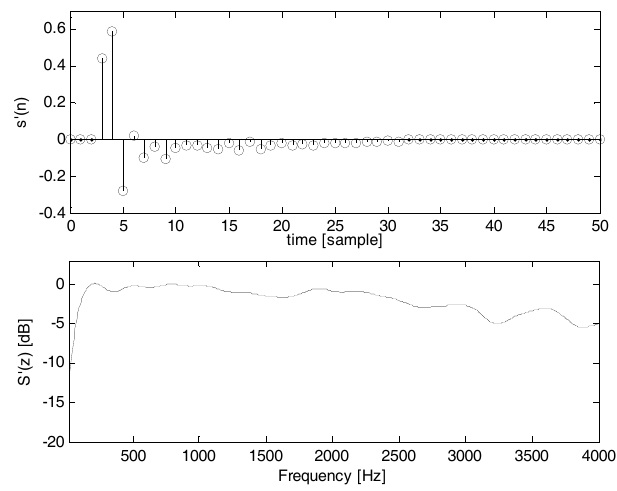
Figure 7. The impulse response ( upper ) and frequency response ( lower ) measured from a practical commercial headphone. This spectral distortion component is applied in simulations.